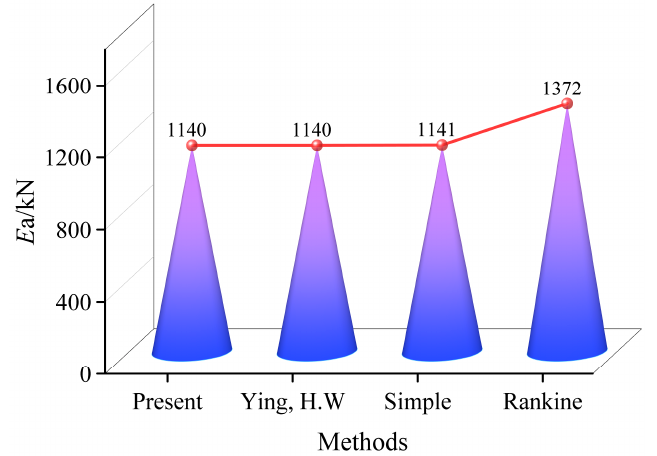
Figure 9. Resultant force of finite soil pressure compared with those of previous studies.